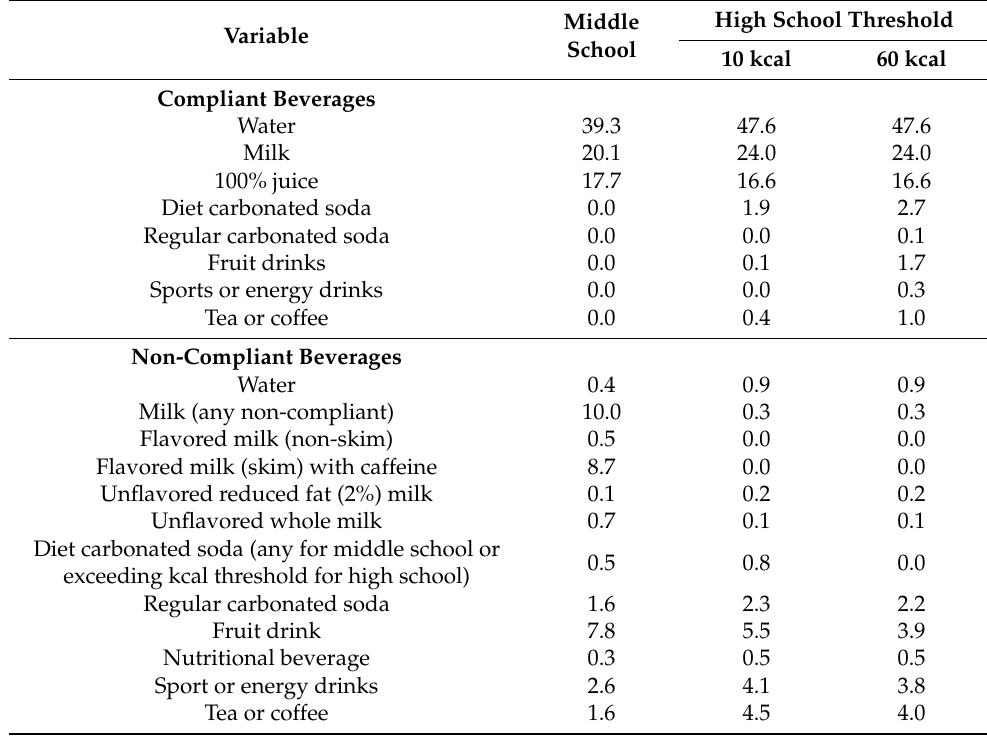
Table 3. Weighted percentage of students consuming Smart Snacks-compliant and non-compliant beverages at school by school level and kcal threshold